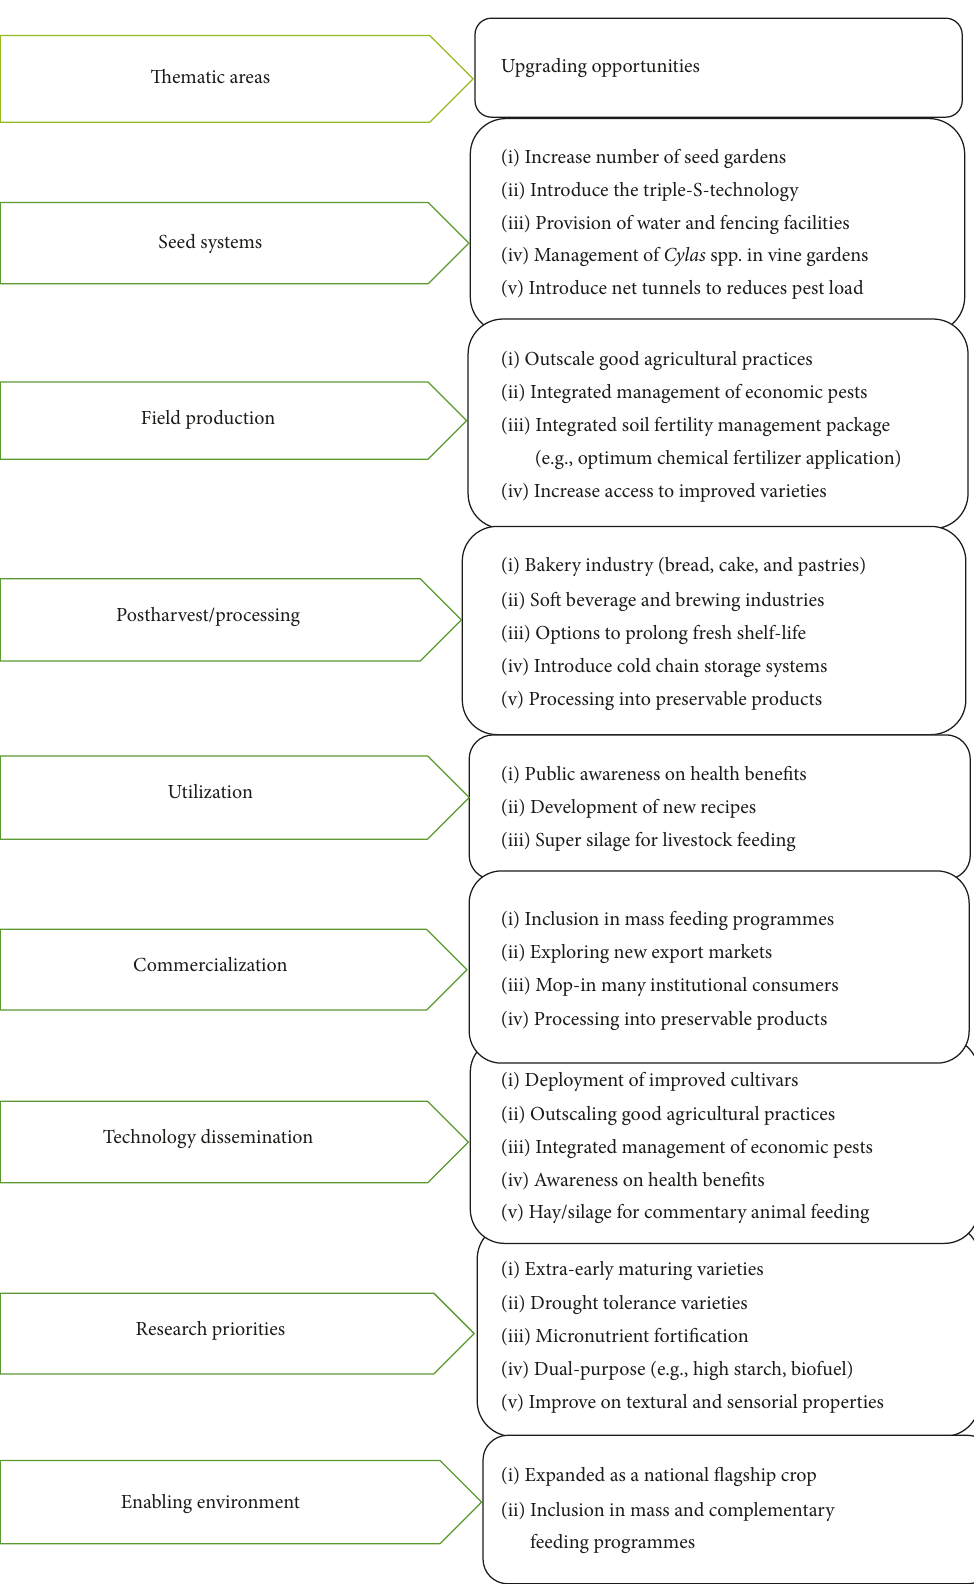
Figure 3: Value chain upgrading opportunities in